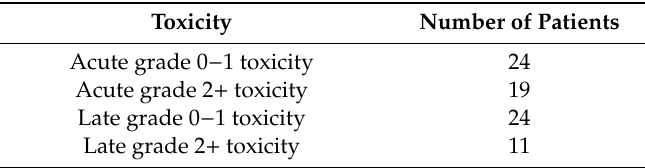
Table 2. Number of patients showing acute and late toxicity immediately following completion of radiotherapy and at 8 months post radiotherapy.